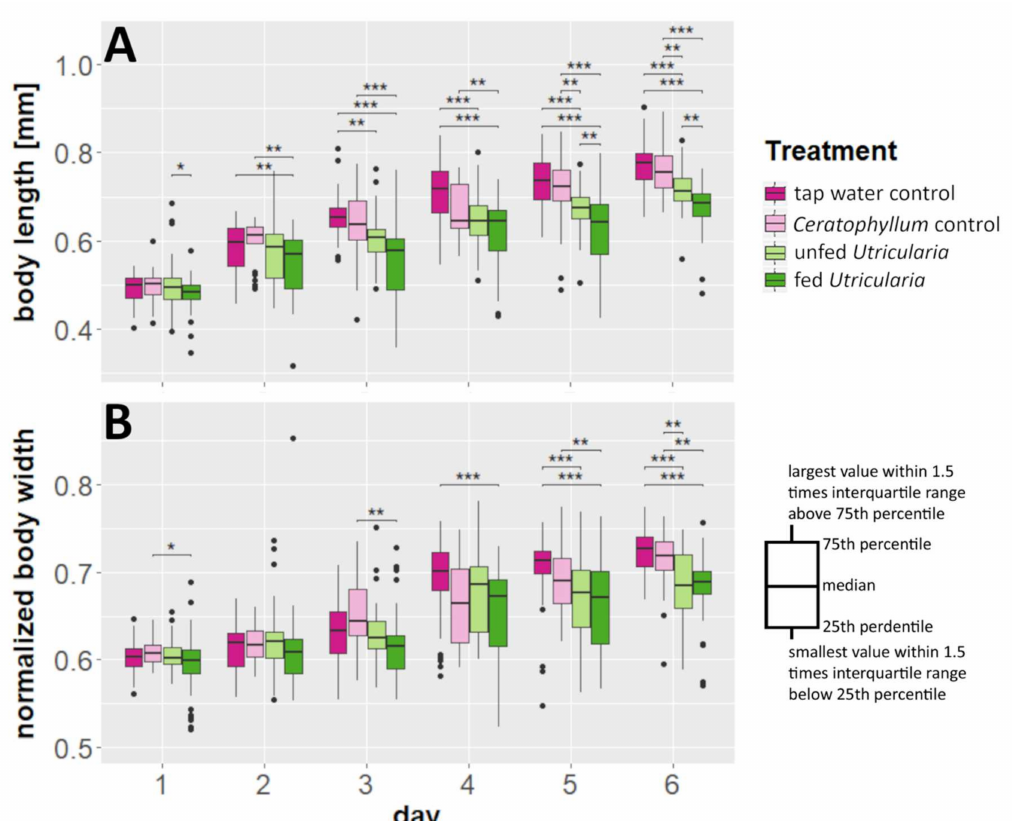
Figure 1. Morphological changes in C. dubia as a response to the presence of U. x neglecta . ( A ) Body length measurements over a duration of 6 days for four different treatments including two control treatments and two Utricularia -exposed treatments. ( B ) Normalized body widths (body width/body length). Utricularia -exposed animals show significantly smaller body length and normalized body width than the control treatments. * p < 0.05; ** p < 0.01; *** p <